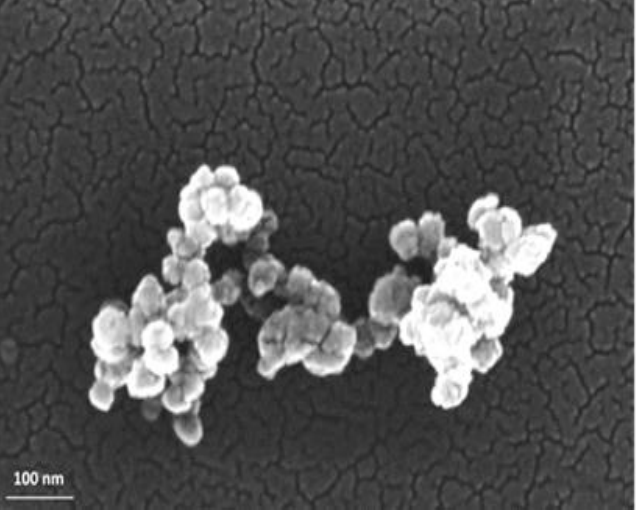
Figure 1. FE-SEM image of SiC NPs at high magnification.